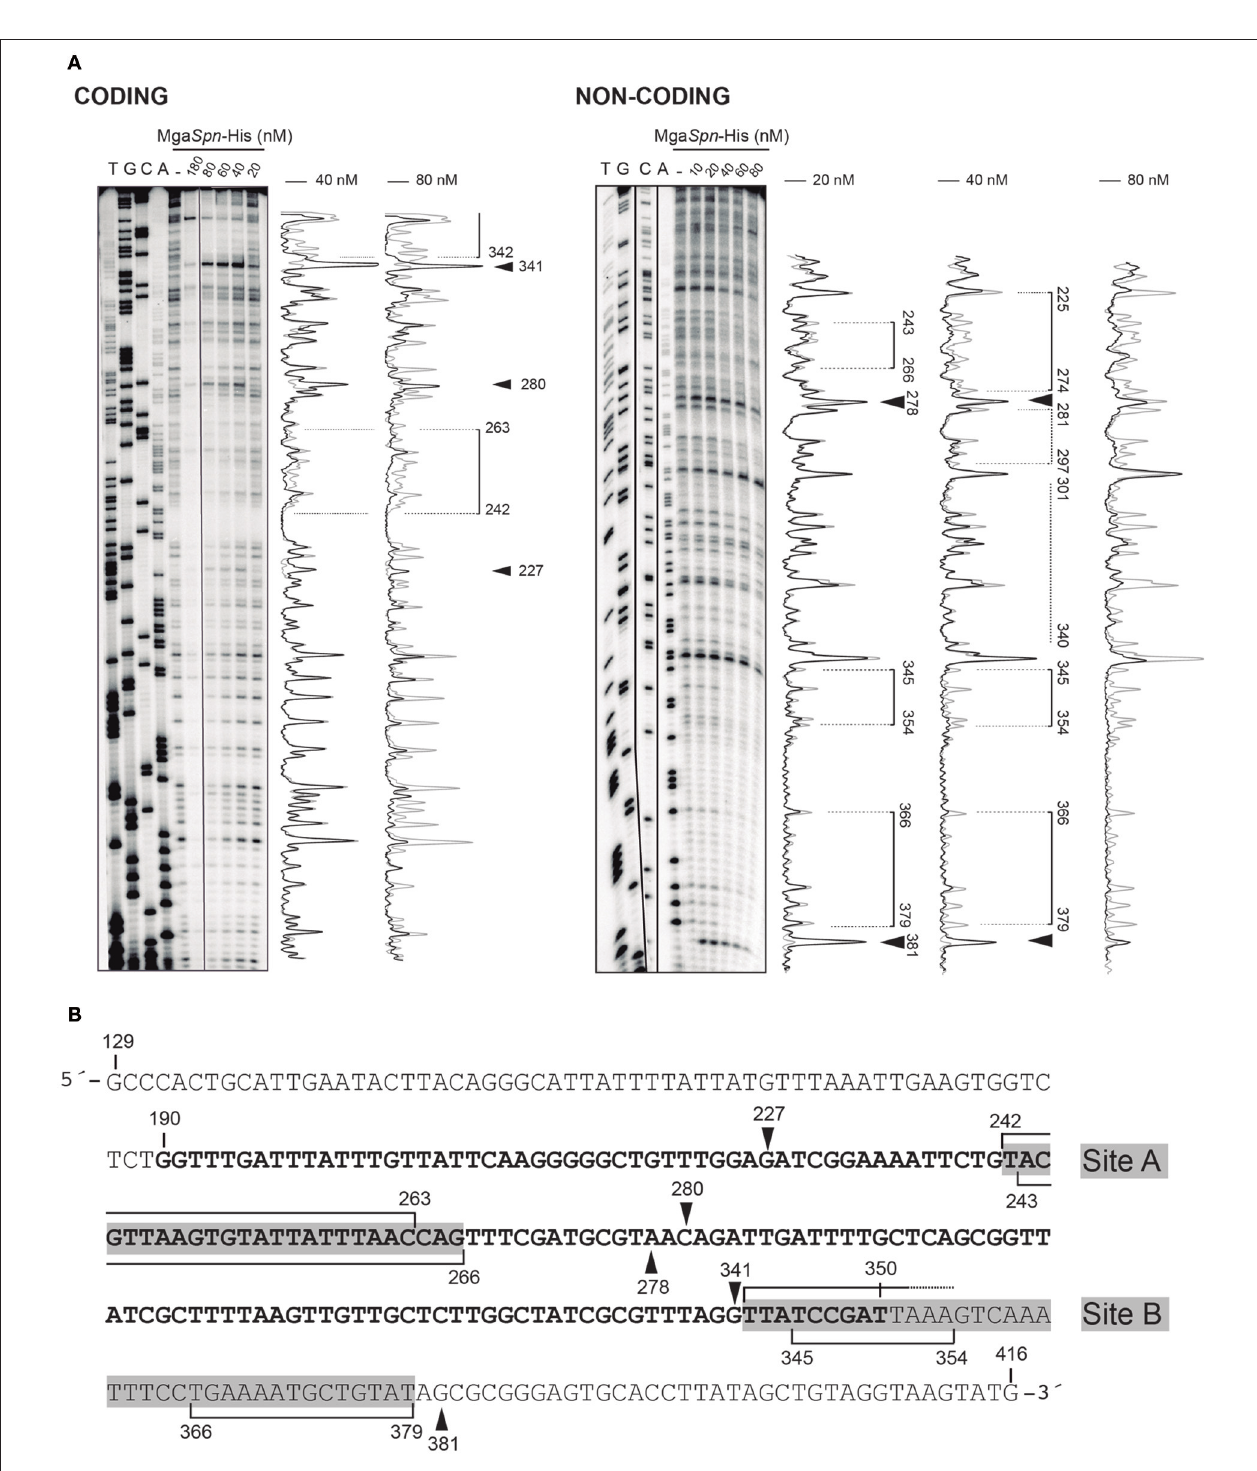
FIGURE 3 | DNase I footprints of complexes formed by Mga Spn -His on the 288-bp hlyR DNA fragment. (A) The hlyR DNA fragment (coordinates 129–416) was radioactively labeled at the 5 ′ -end of either the coding or the non-coding strand. Labeled DNA (2 nM) was incubated with the indicated concentrations of Mga Spn -His and then digested with DNase I. Dideoxy-mediated chain termination sequencing reactions were run in the same gel (lanes A, C, G, T). Densitometer scans corresponding to free DNA (gray line) and DNA with protein (black line) are shown. Brackets represent the Mga Spn -His protected regions. Sites more sensitive to DNase I cleavage are indicated with arrowheads. (B) Nucleotide sequence of the hlyR DNA fragment. The H-NS binding site I (coordinates 190–350) is highlighted in bold. The two sites recognized by Mga Spn -His (sites A and B) are marked with gray boxes. Mga Spn -His protected regions on either the coding or the non-coding strand (brackets) as well as sites more sensitive to DNase I cleavage (arrowheads) are